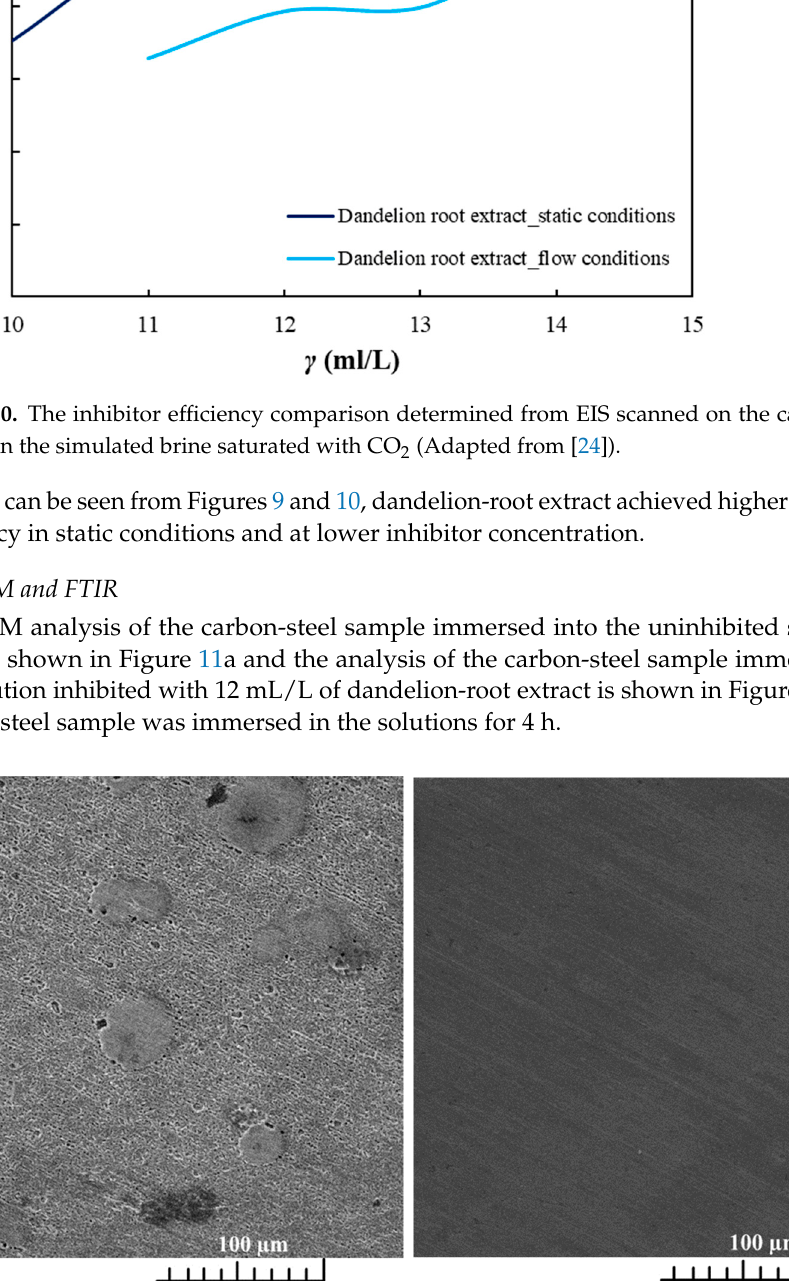
Figure 9. The inhibitor efficiency comparison determined from polarization curves scanned on the carbon ‐ steel sample in the simulated brine saturated with CO 2 (Adapted from [24]).